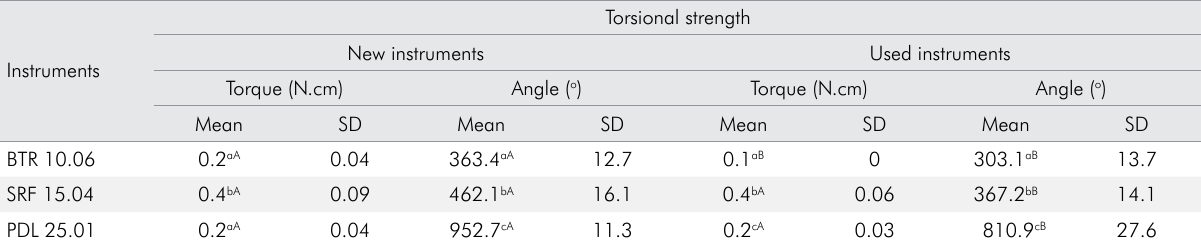
Table 3. Mean values for torque (N.cm) and angle of rotation ( o ) of new instruments and used ones (after three uses).